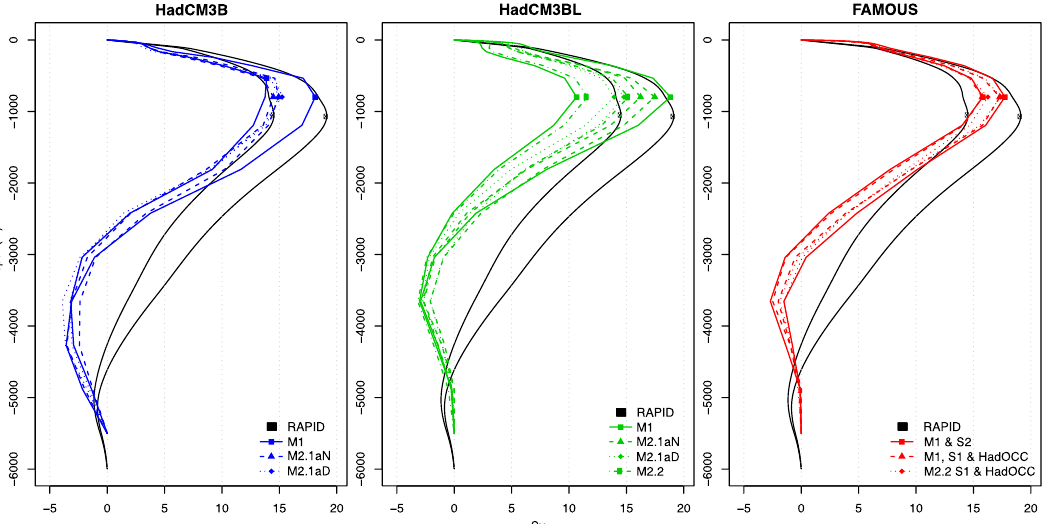
Figure 8. Annual depth profiles of the Atlantic Meridional Overturning Circulation (AMOC) at 26.25 ◦ N showing the range of values for variants of HadCM3B, HadCM3BL, and FAMOUS. Annual data from the RAPID array at 26.5 ◦ N are highlighted in grey. The depth at which the AMOC reaches its maximum is indicated with a